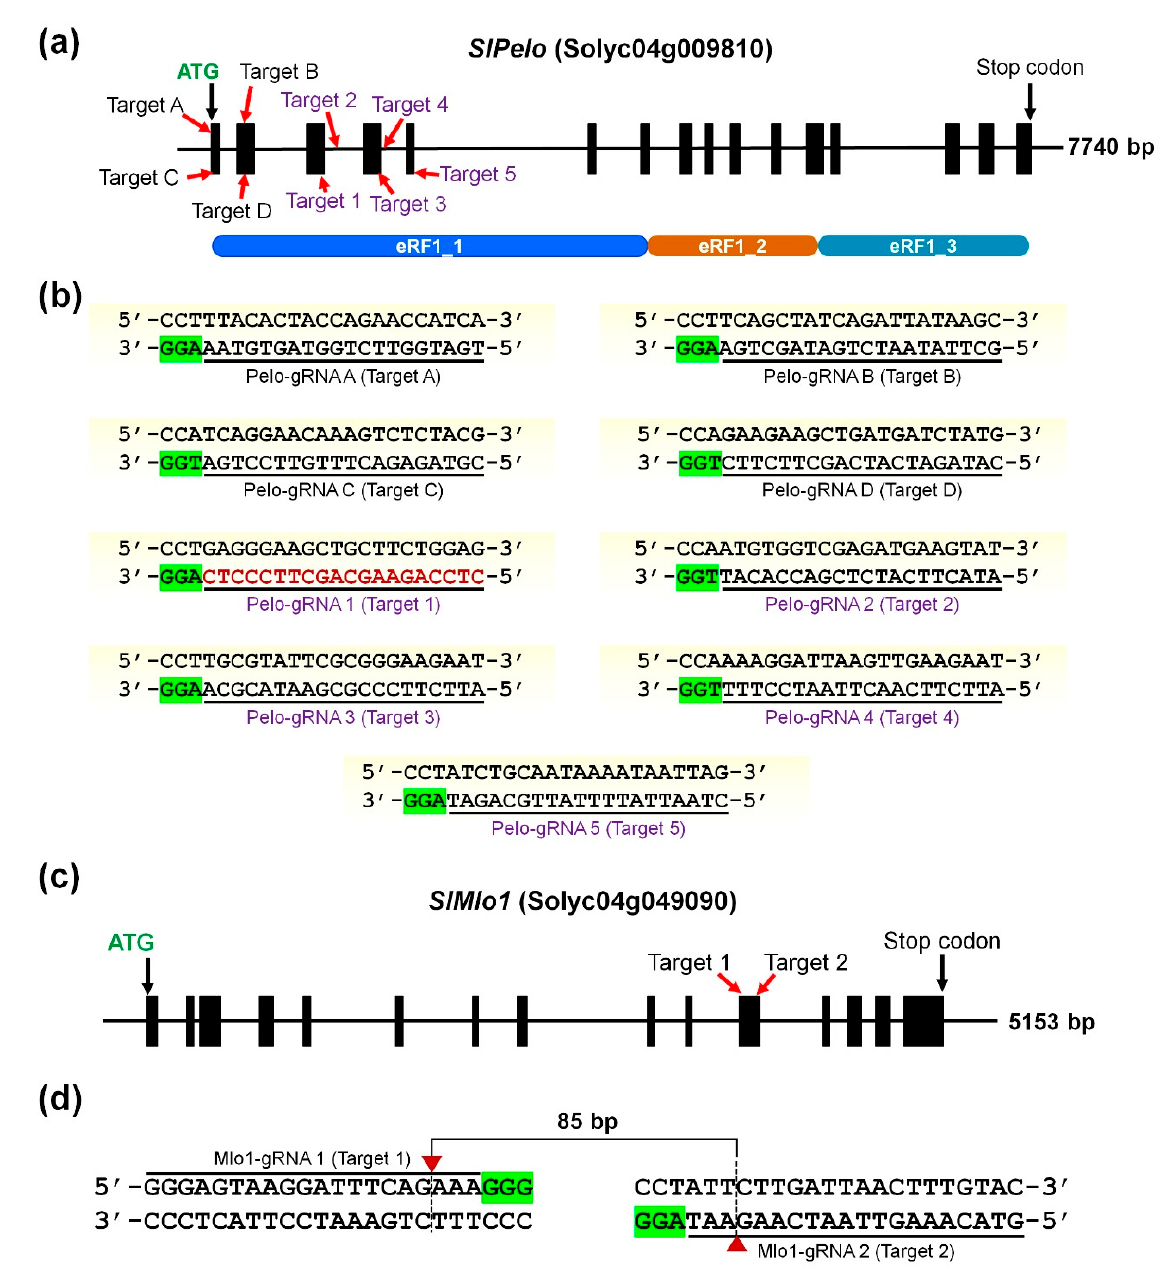
Figure 1. Schematic representation of the clustered regularly interspaced short palindromic repeats (CRISPR)/CRISPR- associated protein (CRISPR/Cas) target sites within SlPelo and SlMlo1 . ( a ) Diagram showing the architecture of SlPelo locus. Black boxes indicate exons, and black lines indicate introns. The target sites are displayed with a red arrow. Three conserved eRF1 domains (eRF1_1, eRF1_2, and eRF1_3) predicted using InterProScan scanning of the Pelota (PELO) are parallelly positioned in the lower panel; ( b ) Nine guide RNAs (gRNAs) (underlined) along with their protospacer adjacent motif (PAM; highlighted in green) are summarized, corresponding to the SlPelo target sites as shown in panel ( a ); ( c ) Diagram showing SlMlo1 architecture. Black boxes represent exons, and black lines indicate introns. The SlMlo1 target sites are displayed with a red arrow; ( d ) The gRNA sequences (underlined) followed by protospacer adjacent motif (PAM; green). Red triangles with a dotted line showing the cleavage position of SpCas9.